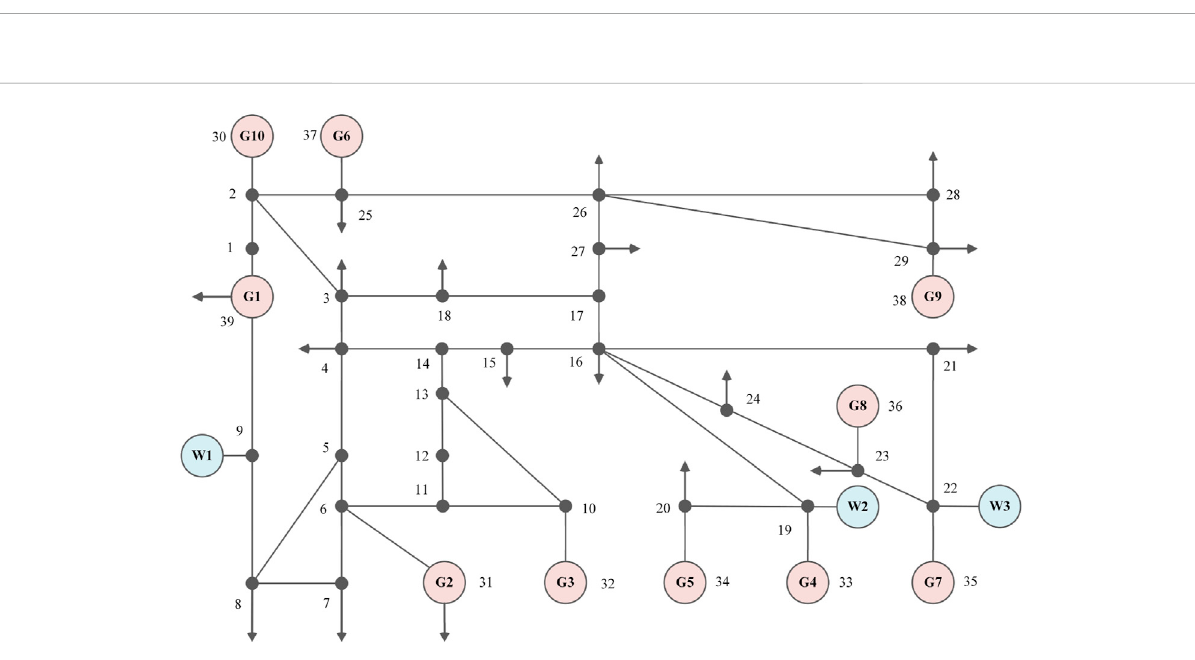
FIGURE 11 IEEE-39 node